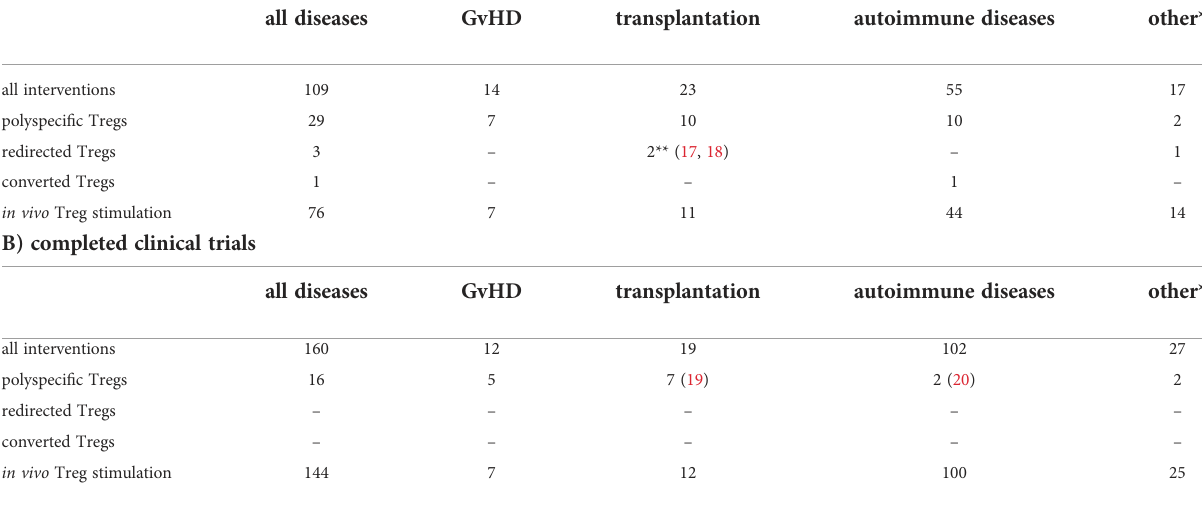
TABLE 1 Clinical trials that use or affect regulatory T